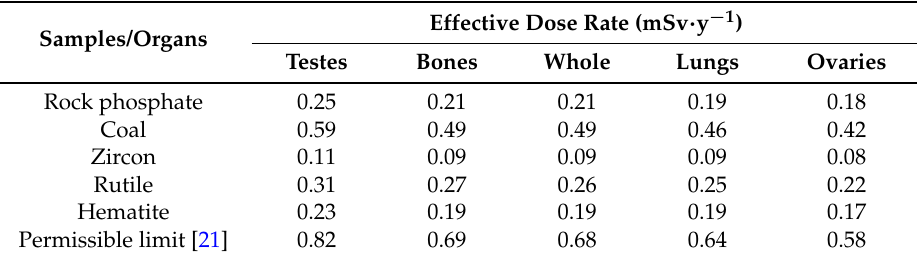
Table 7. Effective annual dose rate delivered to particular organs of the